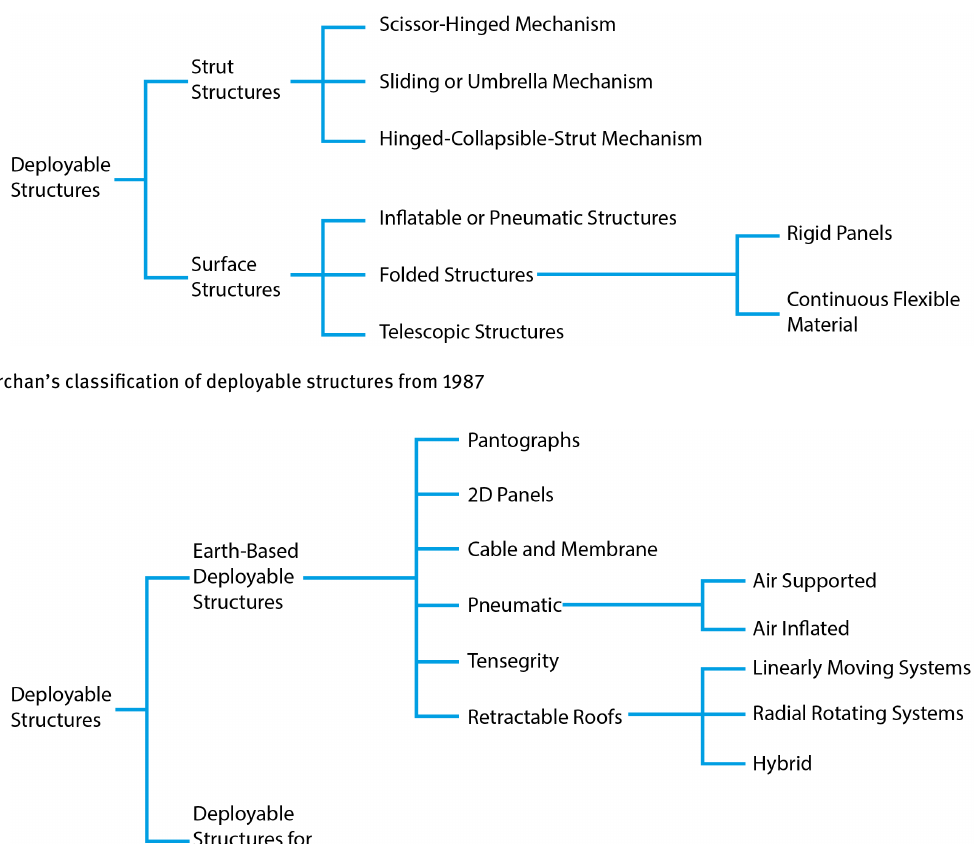
Figure 3: Chronological view of comprehensive and partial classifications of deployable structures published by now